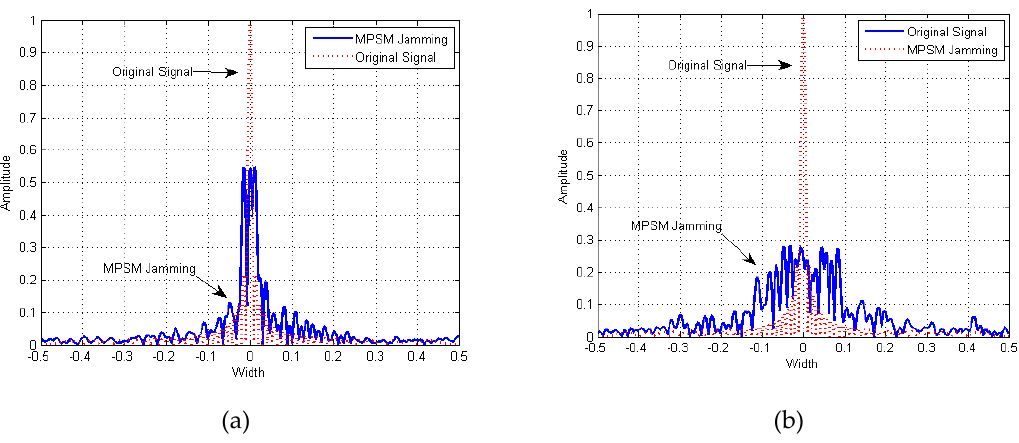
Figure 17. MPSM jamming with optimized phase situation: ( a ) 4 sections and ( b ) 16 sections. Table 11. Results of MPSM jamming in Figure 17.